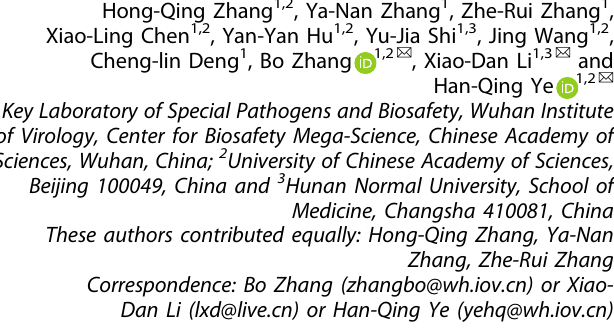
Fig. 1 Development of alphavirus replicon particle vaccine VRP-S-2P against SARS-CoV-2 Omicron variant BA.1. a Schematic diagram of the VEEV-S-2P replicon and VRP construction. The VEEV-S-2P replicon contains two open reading frames (ORF), encoding four non-structural proteins, ns1 – ns4, from Venezuelan equine encephalitis virus (VEEV) and the prefusion-stabilized spike protein of SARS-CoV-2 Omicron variant BA.1. The VEEV-S-2P replicon RNA was co-transfected into BHK cells with two helper RNAs expressing the structural proteins of VEEV, resulting in the production of VRP-S-2P. b , c Indirect immuno fl uorescence and western blot detection of SARS-CoV-2 spike protein followed transfection of VEEV-S-2P and infection of VRP-S-2P at an MOI of 1. Scale bar: 50 μ m. d , i The schematic diagram of the VRP-S-2P vaccination in mouse and hamster model. Female Golden Syrian hamsters aged four- to six-weeks and BALB/c aged six- to eight-weeks were immunized with 1×10 6 FFU VRP-S-2P via intraperitoneal, intramuscular and intranasal routes, respectively. Three immunizations were conducted with two-week